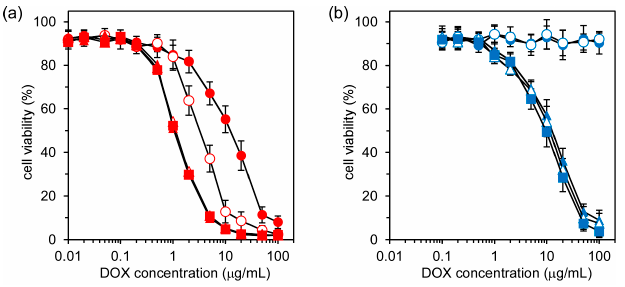
Figure 5. Cont. Figure 5.